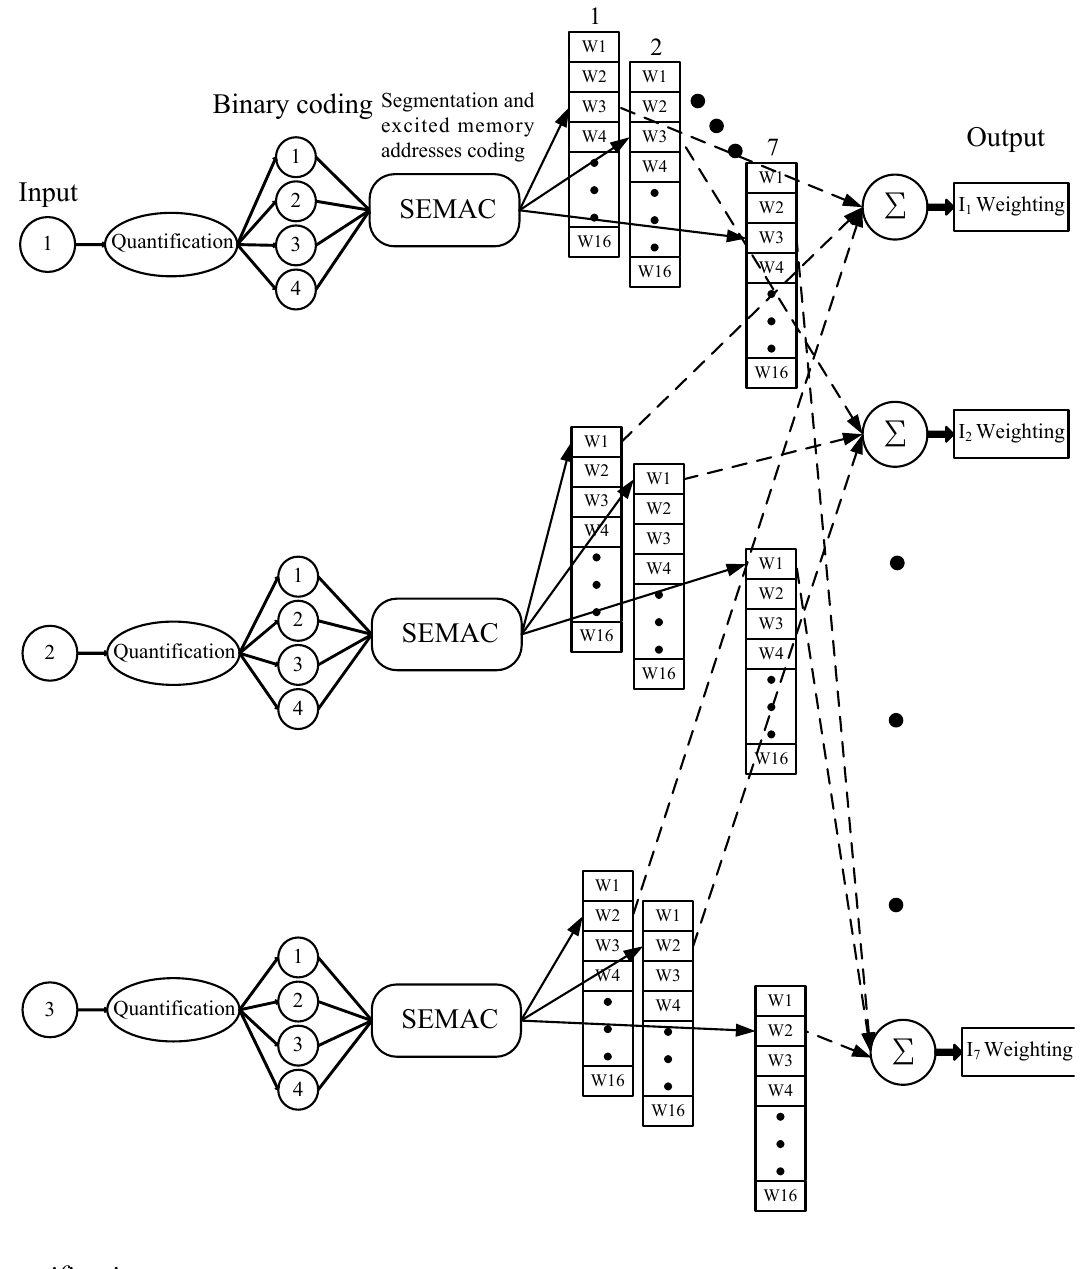
Figure 2. Schematic of the CMAC neural network